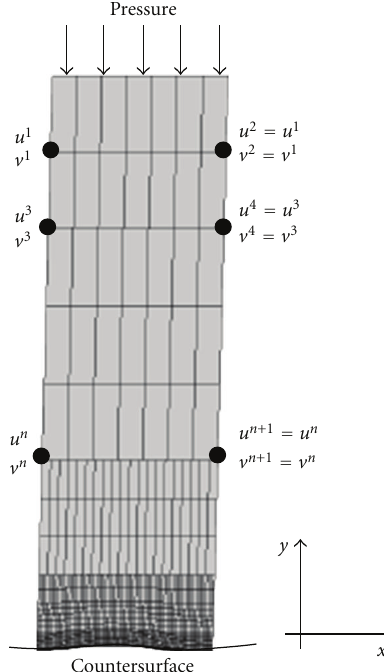
Figure 2: Deformed shape of the FE model and the applied bound- ary conditions. ( u : displacement in x -direction; v : displacement in y